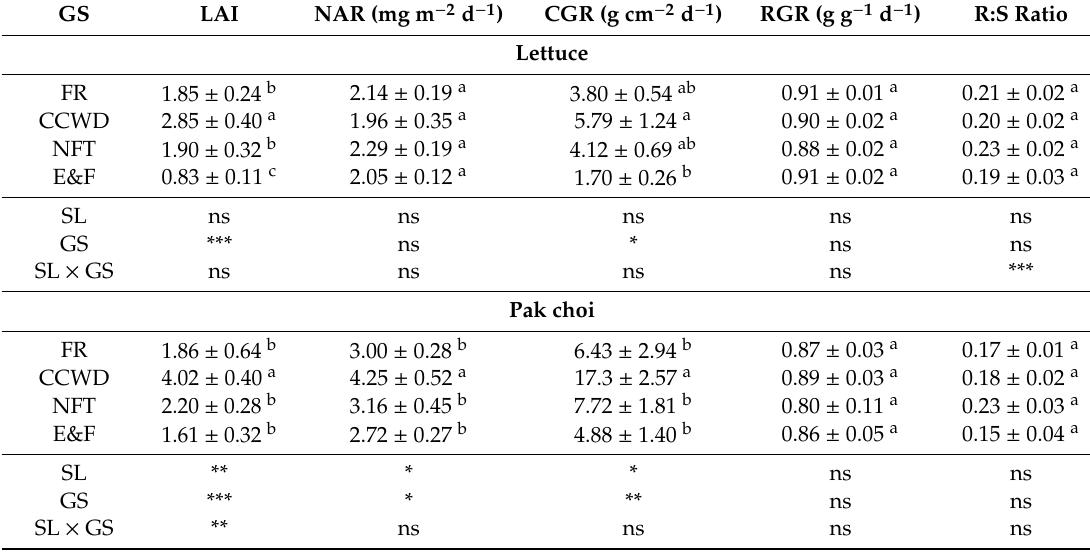
Table 5. Leaf area index (LAI), net assimilation rate (NAR), crop growth rate (CGR), relative growth rate (RGR), and the root-to-shoot ratio (R:S) of lettuce and pak choi cultivated in di ff erent aquaponic